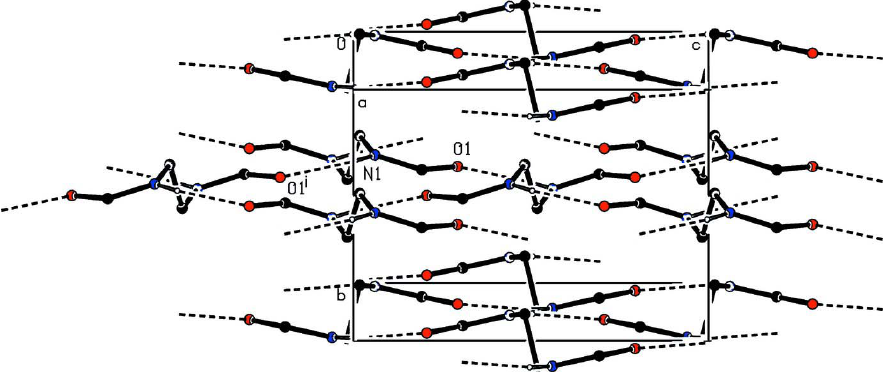
Figure 1 A view of the molecular structure of (I) with the atom-labeling scheme. Displacement ellopsoids are drawn at the 50% probability level and H atoms are shown as small spheres of arbitrary radii. [Symmetry code:(i) 1- x, 1- y , 1- z ]